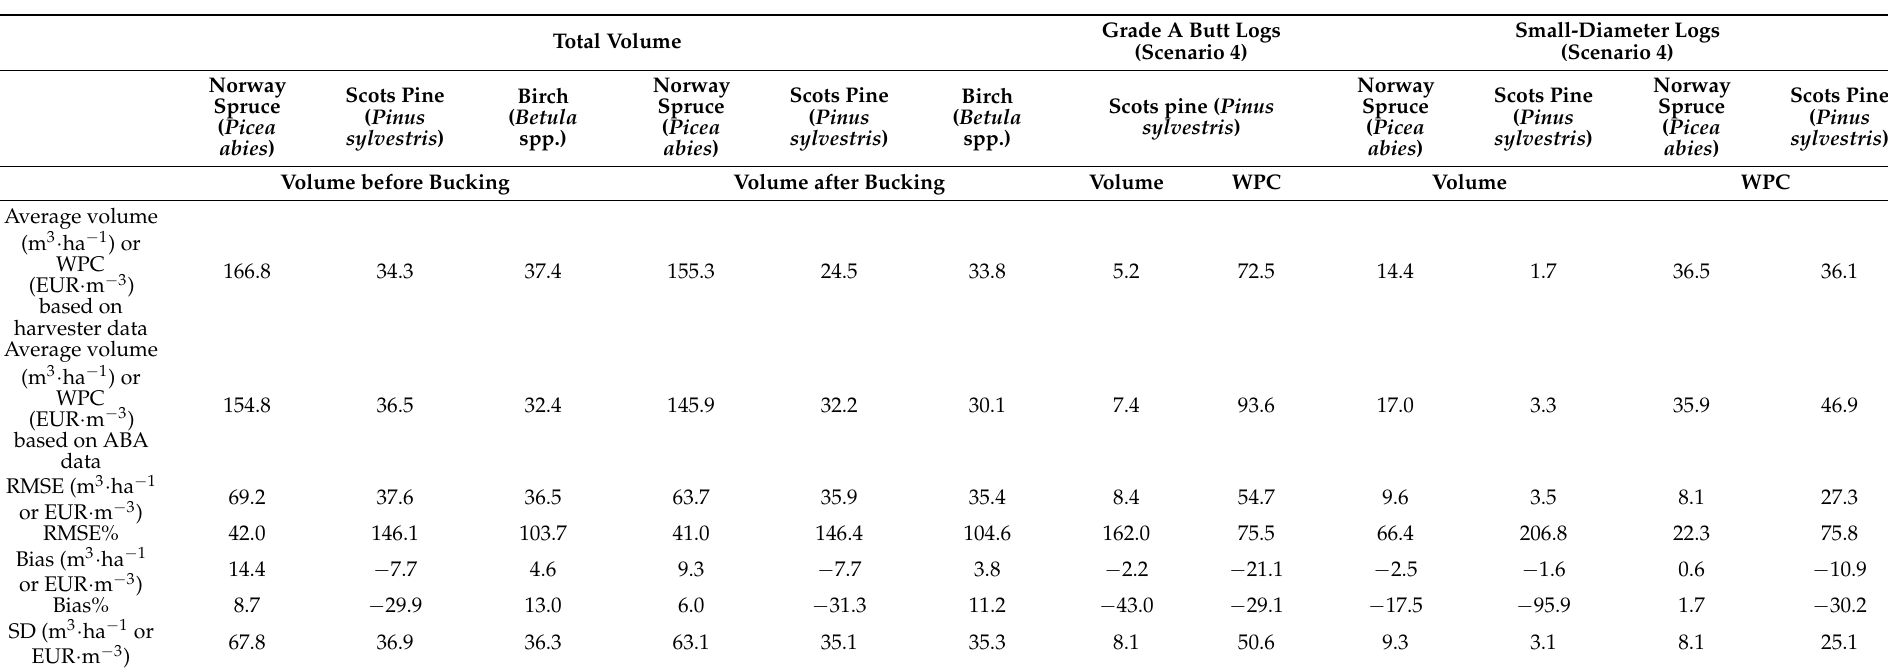
Table 6. Volume and wood paying capability (WPC) estimates for the total volume and timber assortments of grade A butt logs and small-diameter logs and their error statistics at the stand level ( n = 249